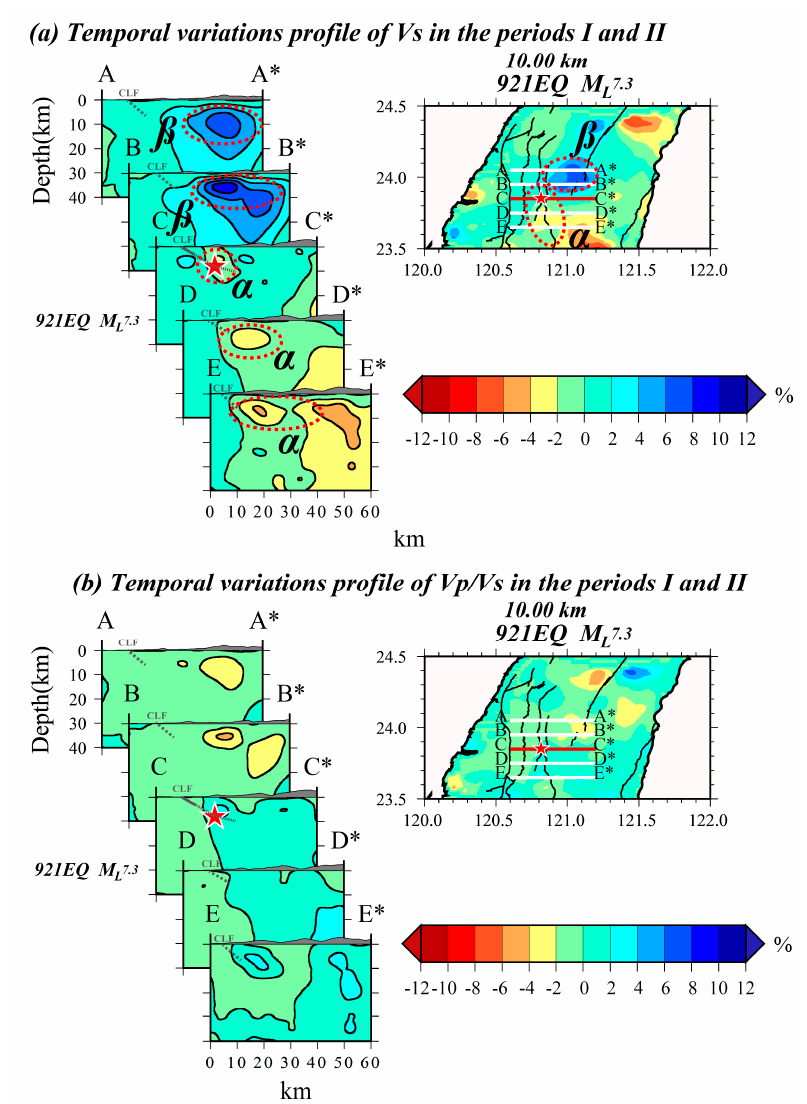
Figure 12. The AA* to EE* profiles analyzed in this study are displayed in the left panel. The profile across the Chi-Chi earthquake uses gray dotted line and red star to indicate the location of the CLF and the mainshock, respectively. The right panel shows the location of the AA* to EE* profiles. The profile CC* across the Chi-Chi earthquake are depicted with the thick red line. ( a ) Temporal variation profile of Vs in the periods I and II. ( b ) Temporal variation profile of Vp/Vs in the periods I and II. In the β area (near the hypocenter), Vp/Vs decreased by approximately 6% and Vs in- creased by approximately 10%. The fluid-filled fractured region at the α area (hypocenter) was assumed to lead to fissure expansion; therefore, the decline of Vs was greater than Vp. Fur- thermore, in the south to north sections of Vs, Vs changed along an eastward-tilted inclined plane. Moreover, Vs changed more significantly south of the hypocenter compared with the north. This phenomenon occurred before the Chi-Chi earthquake and was concentrated south of the CLF. However, the variations in the β area were opposite to those in the α area. In contrast, in this study, we discuss the velocity variation over a long time scale before the occurrence of the earthquake sequence; we found remarkable changes in peri- ods I and II, such as the decrease in Vs in the α region and the increase in Vs in the β